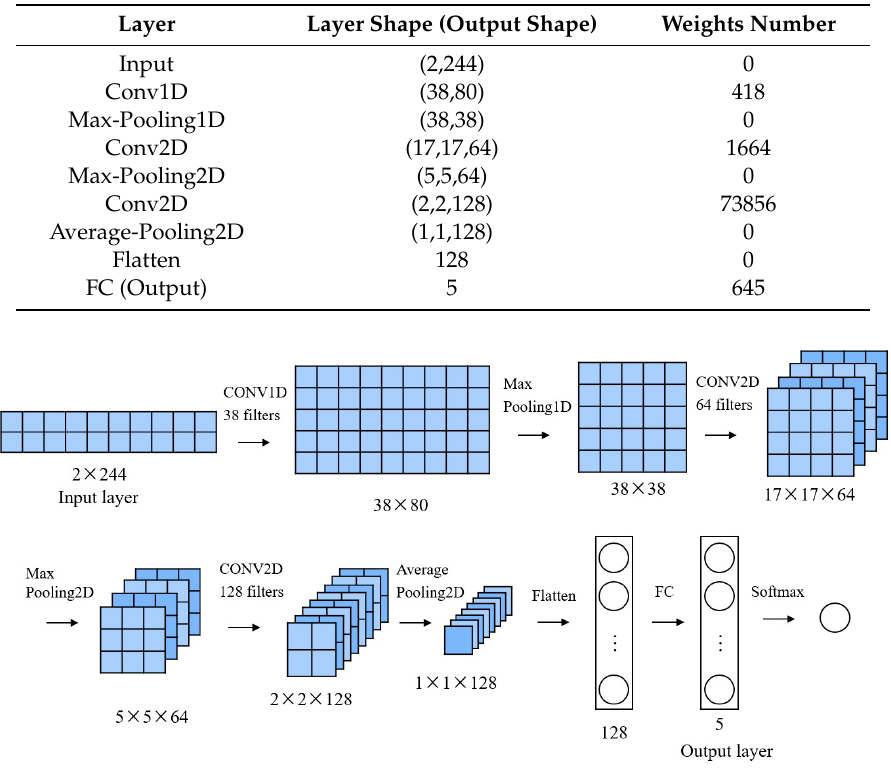
Figure 6. Schematic diagram of CNN structure. Table 2. The layer shape and weights number of CNN.